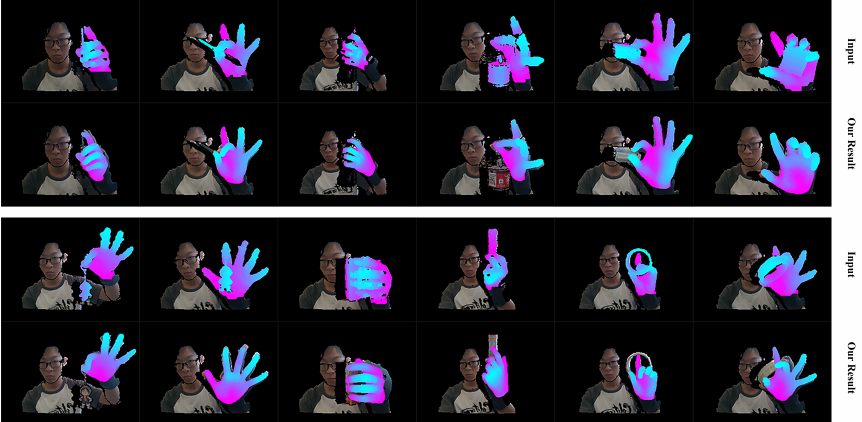
Figure 25. The real-time performance of our system with occlusion from some small items. There are two rows. For each row, the upper one shows the hand segment of the input depth after pseudo-color enhancement, while the lower one shows the rendered depth image from the recovered hand model after pseudo-color enhancement.